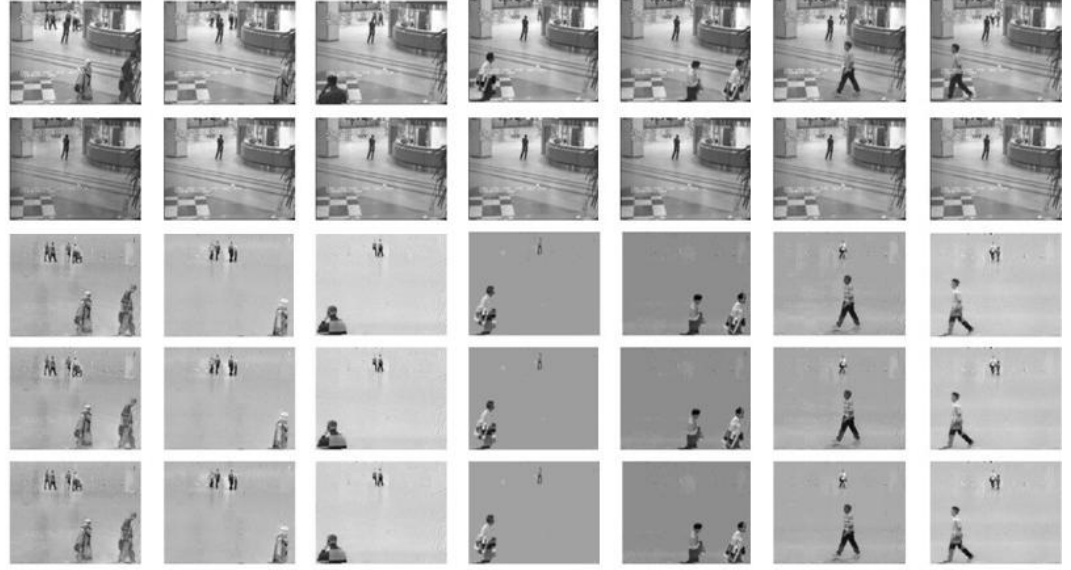
Figure 6. Foreground recovery from video compressive sensing on ―airport‖ dataset. The 1 st row is the original video frames; the 2 nd row shows the estimated background images by IALM [21] that are used to train our fixed low-rank subspace; the 3 rd row shows   ; the 4 th row shows the the recovered foreground with CS measurement ratio 30% cs recovered foreground with ; and the last row shows the recovered foreground with